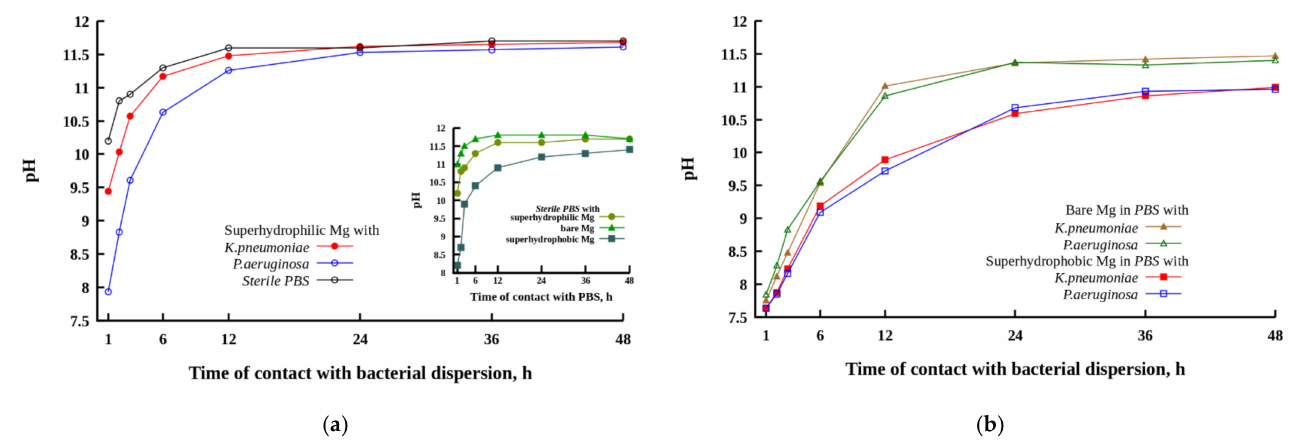
Figure 4. Variation of pH with a time of contact between bacterial dispersions and MA8 alloy sample with the super- hydrophilic coating ( a ), and the superhydrophobic coating and bare MA8 alloy ( b ). Inset shows the time evolution of pH in sterile PBS with the immersed superhydrophilic, superhydrophobic, or bare sample. In the legend, “PBS” denotes phosphate buffer solution without bacteria, and the bacteria names denote the dispersion of the corresponding bacterial strain in PBS. Lines are only to guide